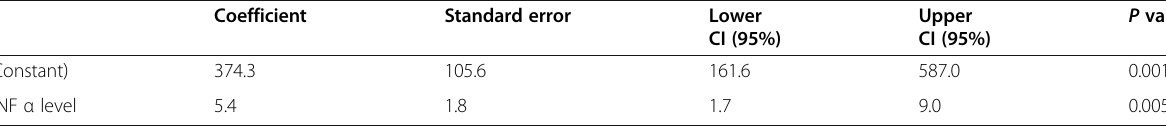
Table 5 Multivariate analysis